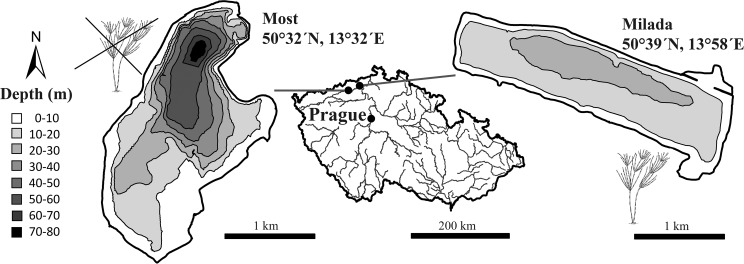
A map showing the location and bathymetric maps of macrophyte-rich Milada Lake and macrophyte-poor Most Lake in northern Czech Republic.